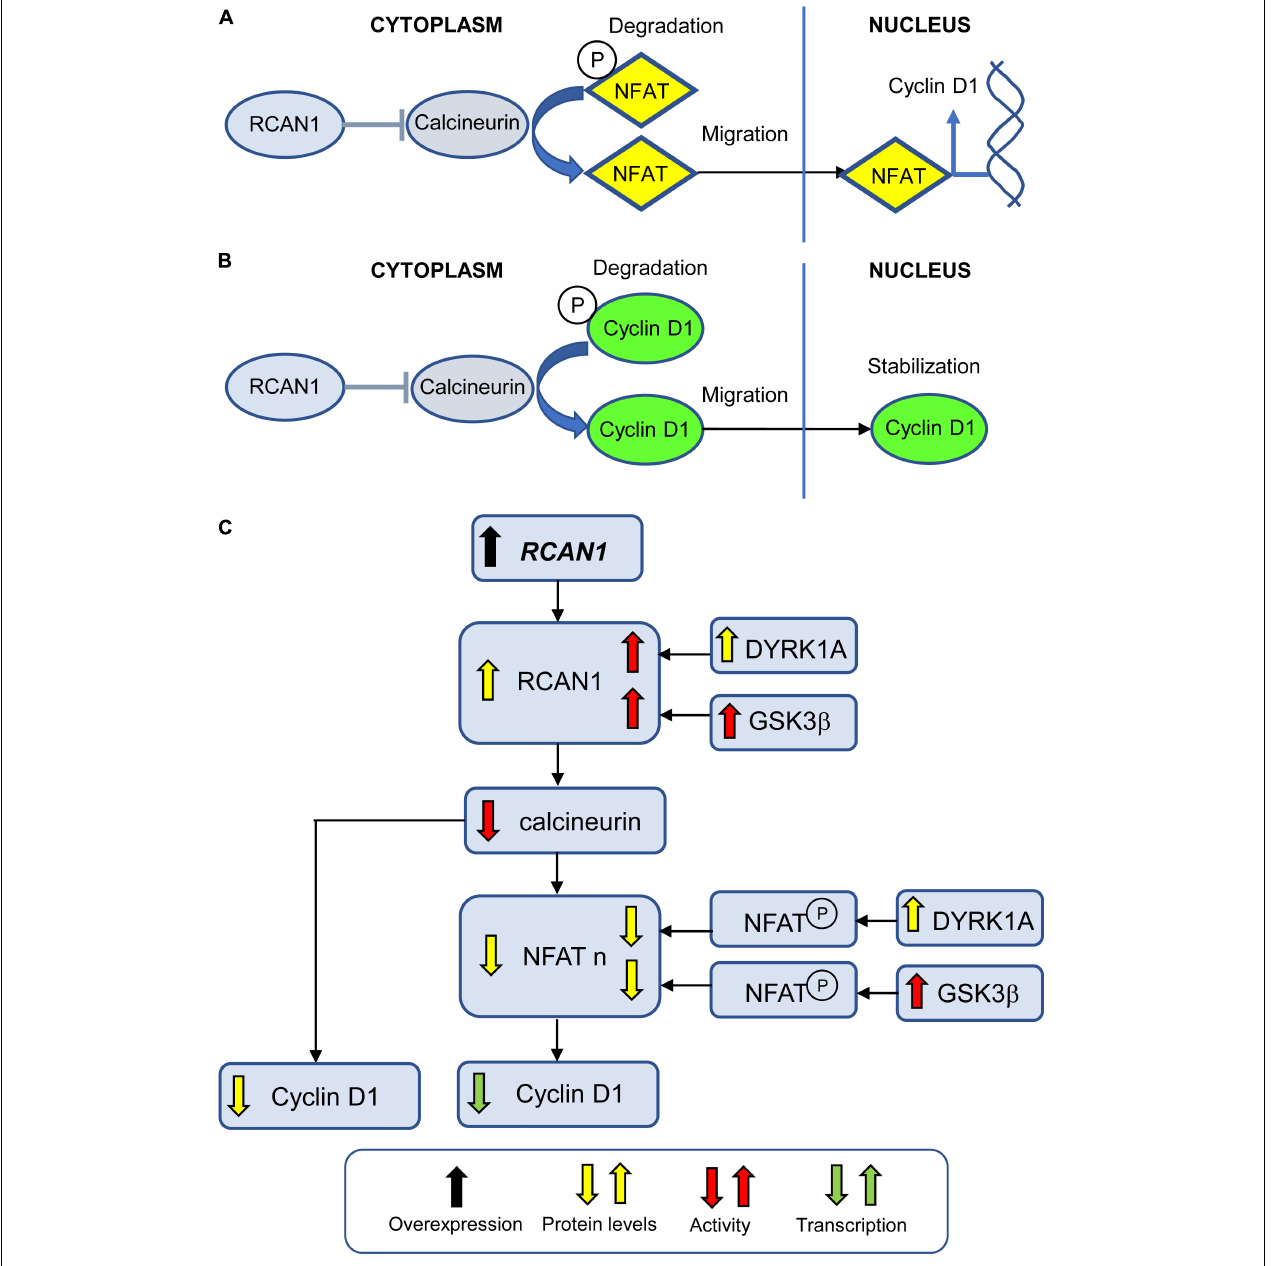
FIGURE 6 | Effect of RCAN1 overexpression on NPC proliferation. (A) Calcineurin dephosphorylates NFAT which allows its translocation to the nucleus where it promotes transcription of various genes, including cyclin D1. Phosphorylated NFAT remains in the cytoplasm where it undergoes degradation. RCAN1 inhibits calcineurin activity, thereby reducing NFAT nuclear translocation. (B) Calcineurin dephosphorylates cyclin D1 which allows its nuclear stabilization. Phosphorylated cyclin D1 remains in the cytoplasm where it undergoes degradation. RCAN1 inhibits calcineurin activity, thereby reducing cyclin D1 stabilization. (C) Excessive levels of RCAN1 increase the inhibition of calcineurin activity. This leads to reduced cyclin D1 protein levels due to its excessive degradation, and to reduced cyclin D1 transcription due to reduced NFAT translocation to the nucleus. DYRK1A and GSK3ß increase the activity of RCAN1, thereby increasing its inhibition on calcineurin. In addition, DYRK1A and GSK3ß enhance NFAT phosphorylation, thereby contributing to its degradation and reducing its nuclear levels. Abbreviations; RCAN1, regulator of calcineurin 1; NFAT, nuclear factor of activated T cell; and NFAT n, nuclear